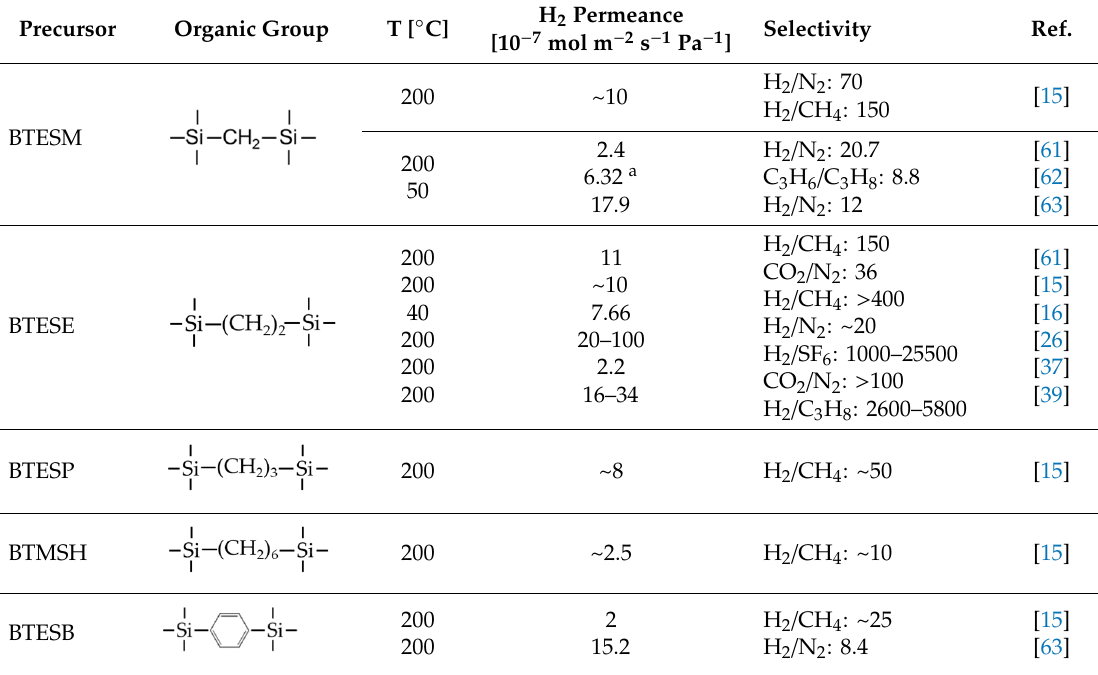
Table 2. Bridged-organosilica membranes and their performance in gas-phase separation. Precursor